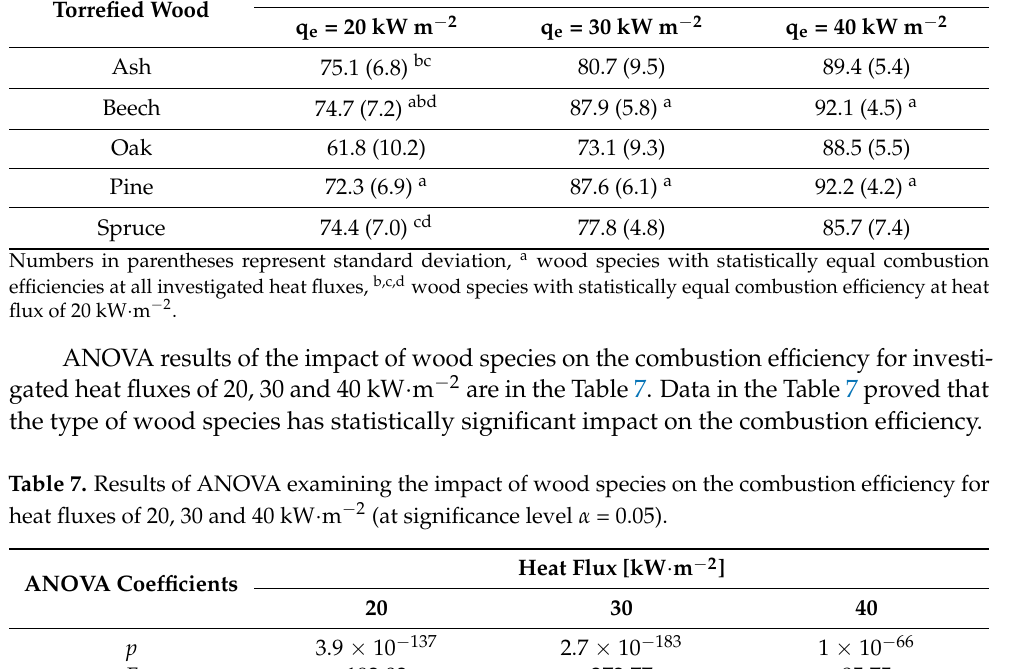
Table 6. Combustion efficiencies of torrefied wood obtained using different heating fluxes. Torrefied Wood